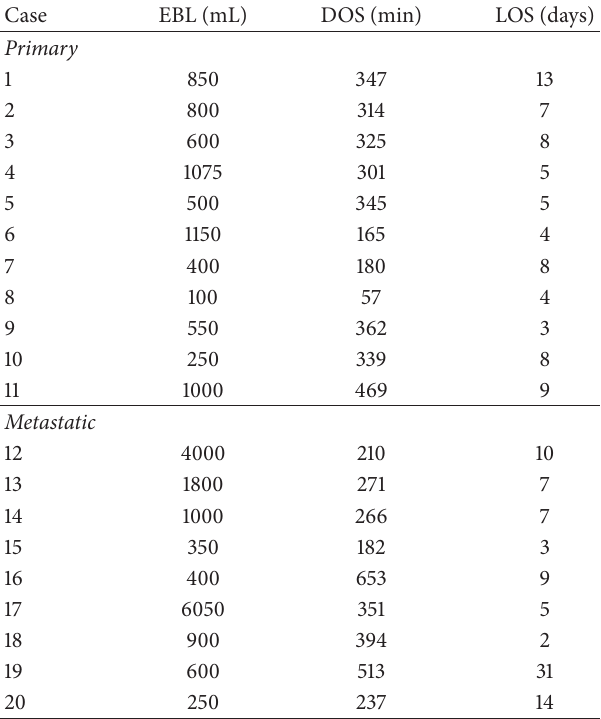
Table 3: Perioperative